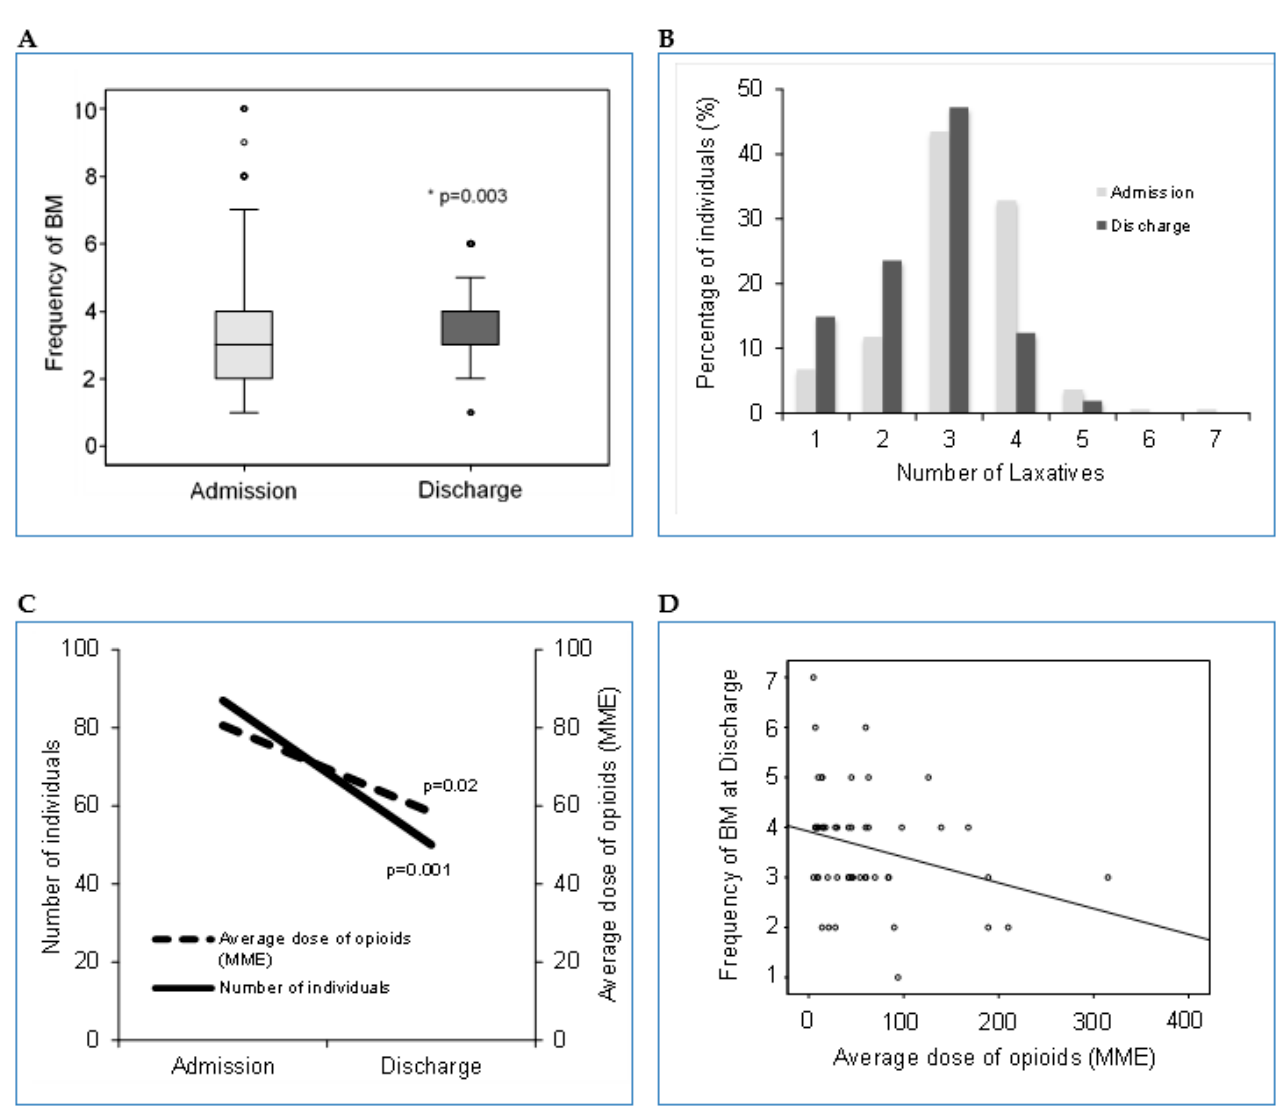
Figure 2. Changes in bowel function and medication use from admission to discharge in our whole cohort of individuals with SCI at an acute rehabilitation setting. ( A ) Frequency of BM at admission and discharge. ( B ) Total number of laxatives taken at admission and discharge. ( C ) Number of individuals taking opioids and average dose of opioids (MME) at admission and discharge. ( D ) Correlation between frequency of BM and average dose of opioids (MME) at discharge. Abbreviations: SCI—spinal cord injury; BM—bowel movement; MME—morphine milligram equivalents. * p -values < 0.01 are considered statistically significant.